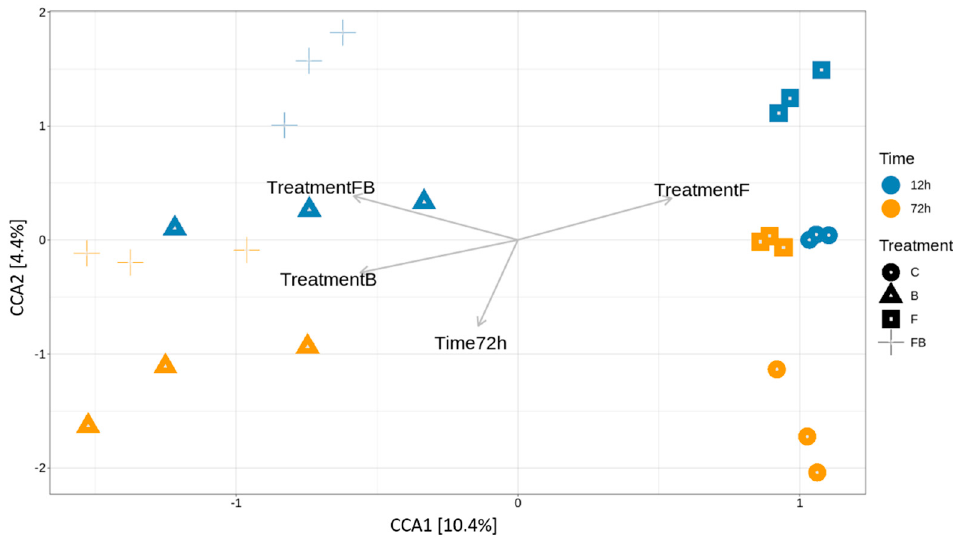
Figure 4. Canonical correspondence analysis (CCA) of the relative variance of OTUs in the soil samples subjected to the different control (C), biosolid − enriched treatment (B), Forl inoculation (F), and Forl inoculation with biosolid application (FB) treatments at 12 and 72 h. The biplots present the effect of biosolid application to the bacterial community abundance in the treatments with or without fungal inoculum at two different timepoints.